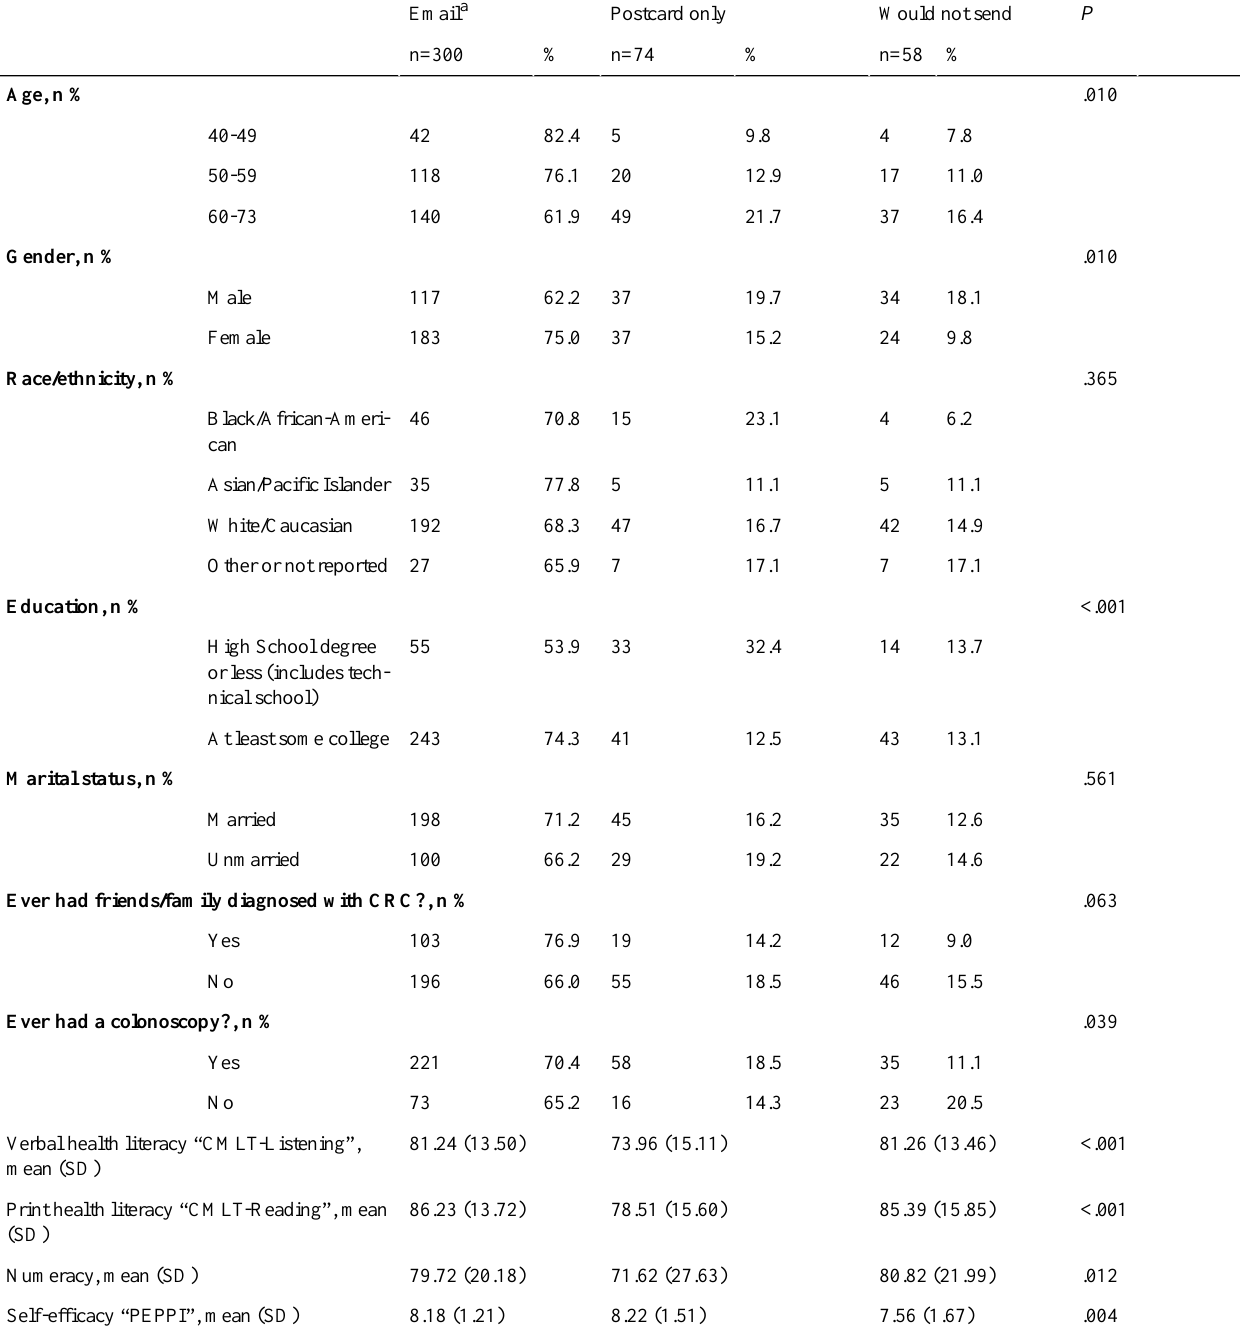
P Would not sendPostcard onlyEmail